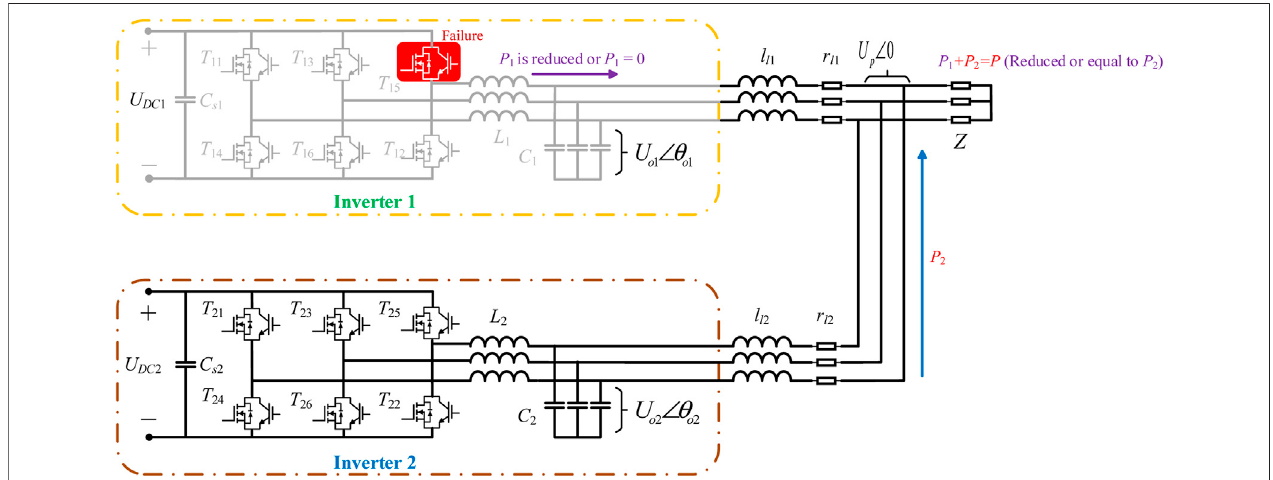
FIGURE 3 | System-level fault-tolerant